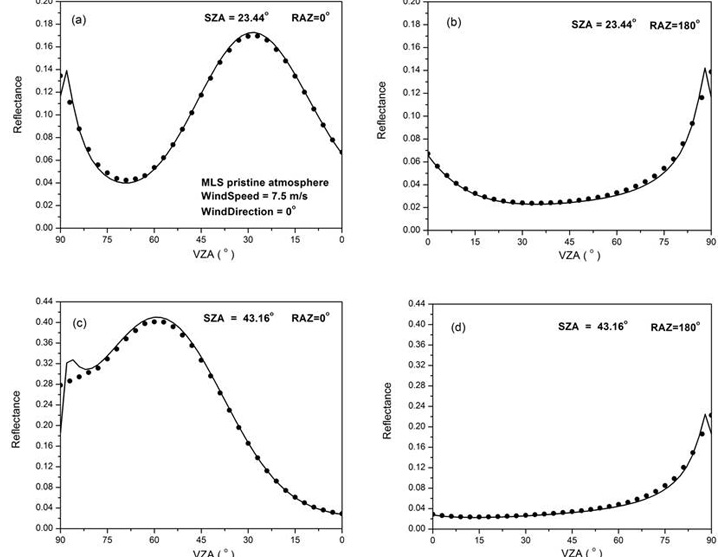
Fig. 4. Comparison of the total reflectance of the ocean–atmosphere system at a wavelength of 670nm on the principal plane. Black dots and solid curves denote the results from the ADRTM and the DISORT, respectively. The atmosphere is of the midlatitude summer (MLS) atmosphere with only Rayleigh scattering and gas absorption. The wind speed is 7.5ms − 1 and wind direction is 0 ◦ . The solar zenith angle (SZA) for (a) and (b) is 23.44 ◦ and for (c) and (d) is 43.16 ◦ . Thirty-six (36) streams are used in the DISORT and 18 streams and 18 Fourier expansion modes in the